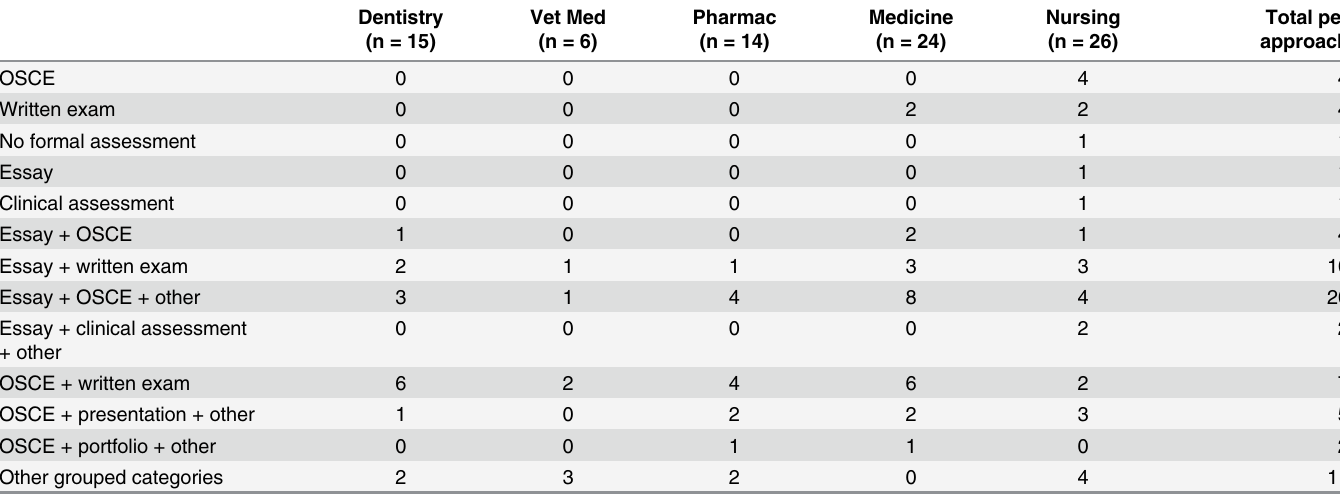
Table 4. Antimicrobial stewardship evaluation methodologies used in undergraduate programmes, by